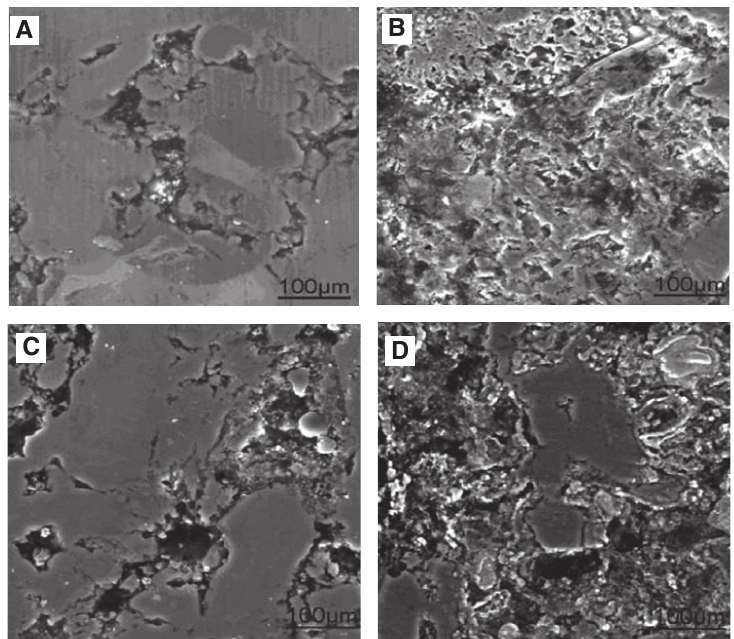
Figure 2 Microstructure of self-lubricating composites with different LiF addition amounts: (A) 5%, (B) 10%, (C) 15%, and (D)